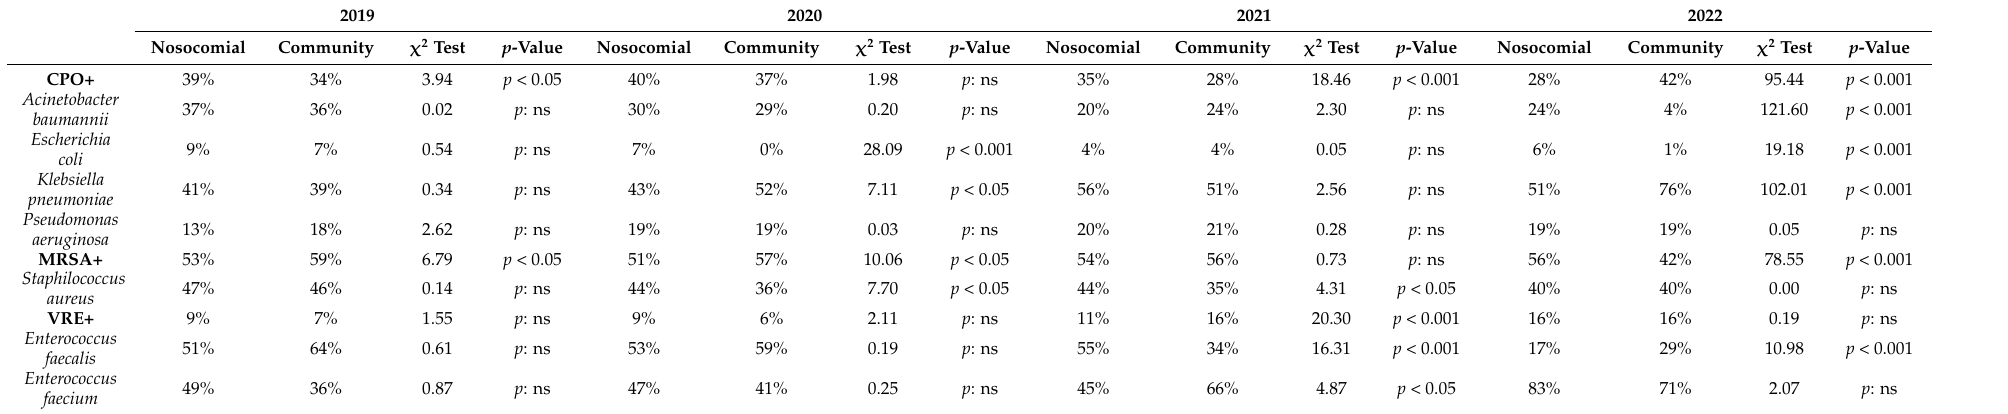
Table 2. Data divided between samples from nosocomial patients (N) and samples from community patients